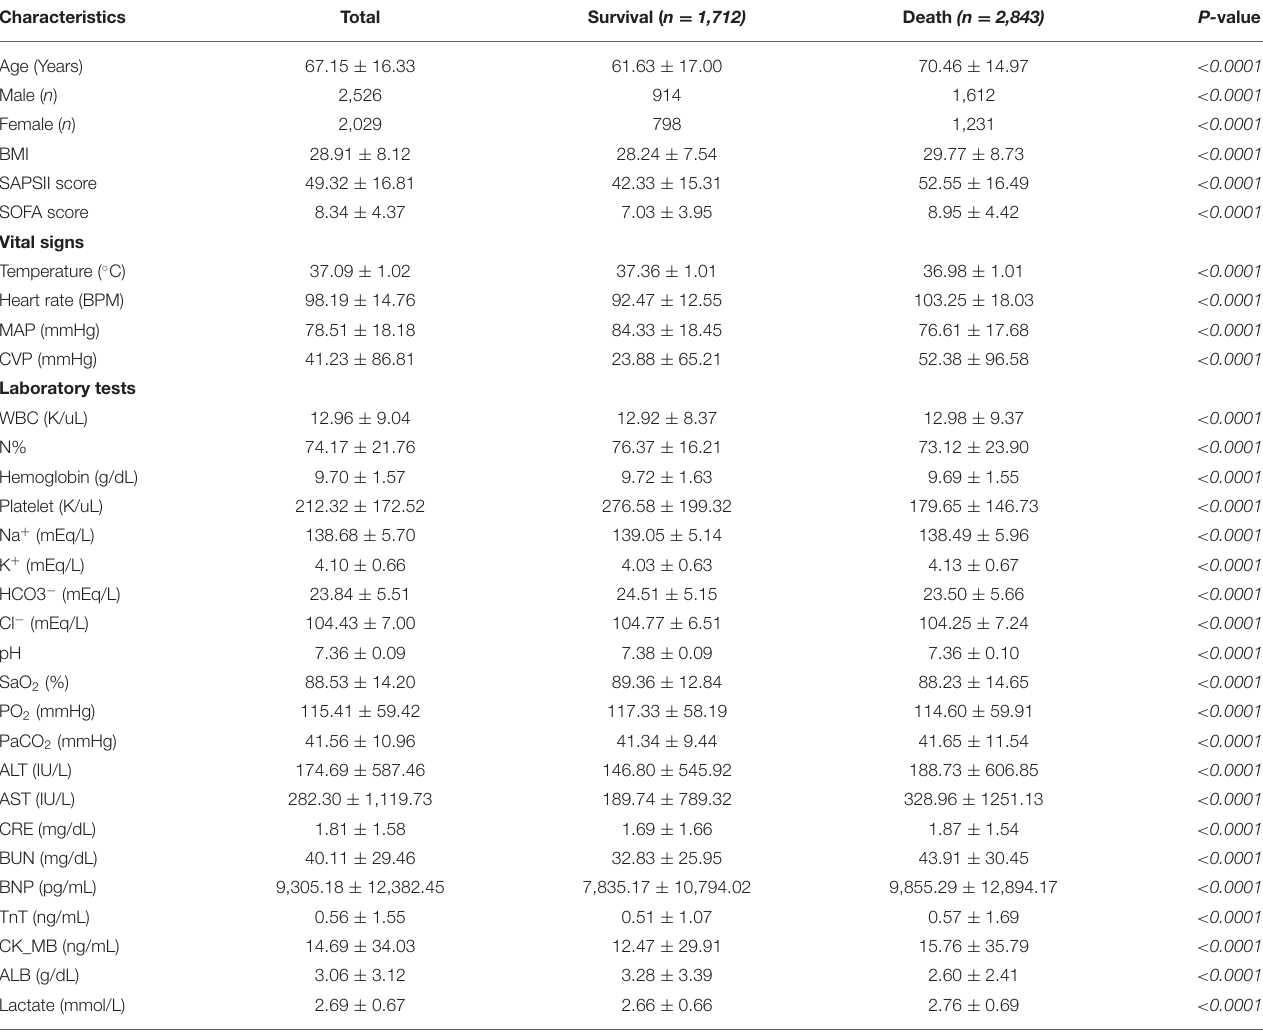
TABLE 2 | Baseline data of patients.